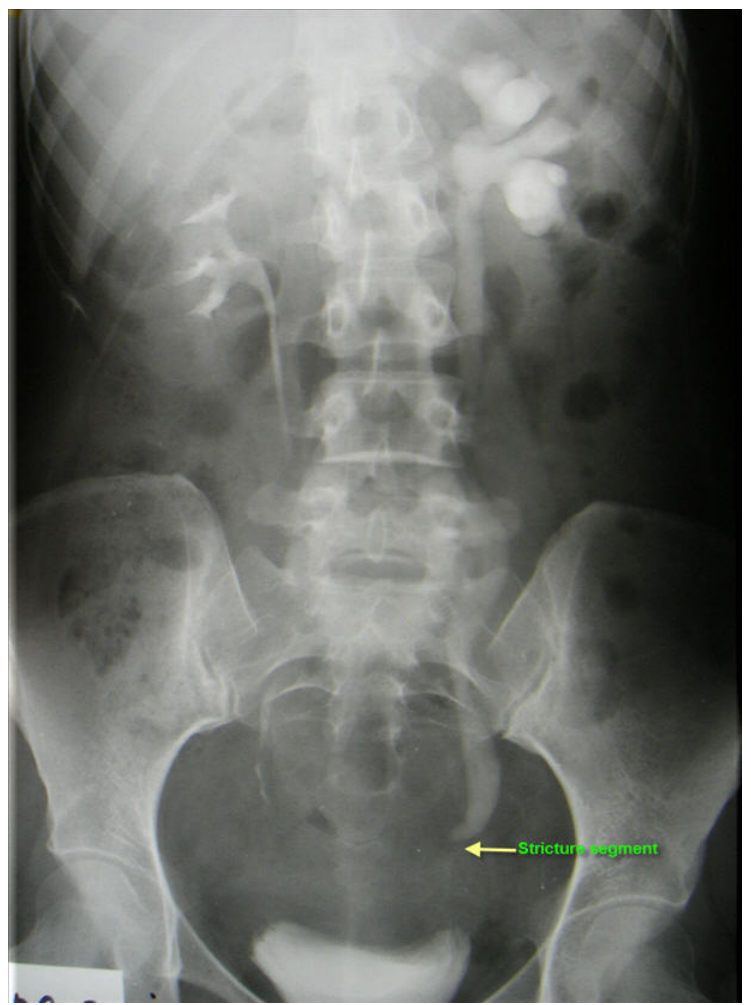
FIGURE 1. IVU showing left lower ureteric stricture with proximal